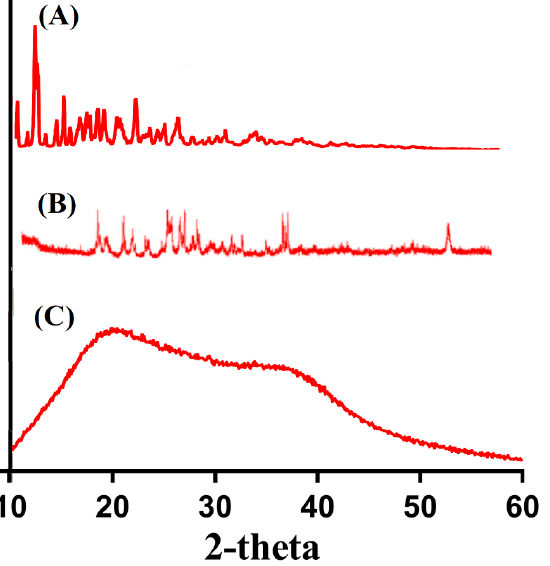
Figure 4. XRD of ( A ) β -CD, ( B ) Ia, and ( C ) β -CD- g -P(Aa/Ia) hydrogel.